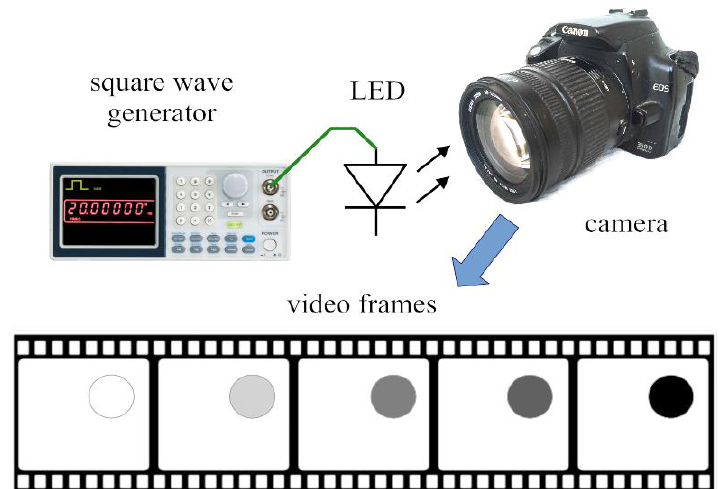
Figure 17. The equivalent sampling-based measurement method.